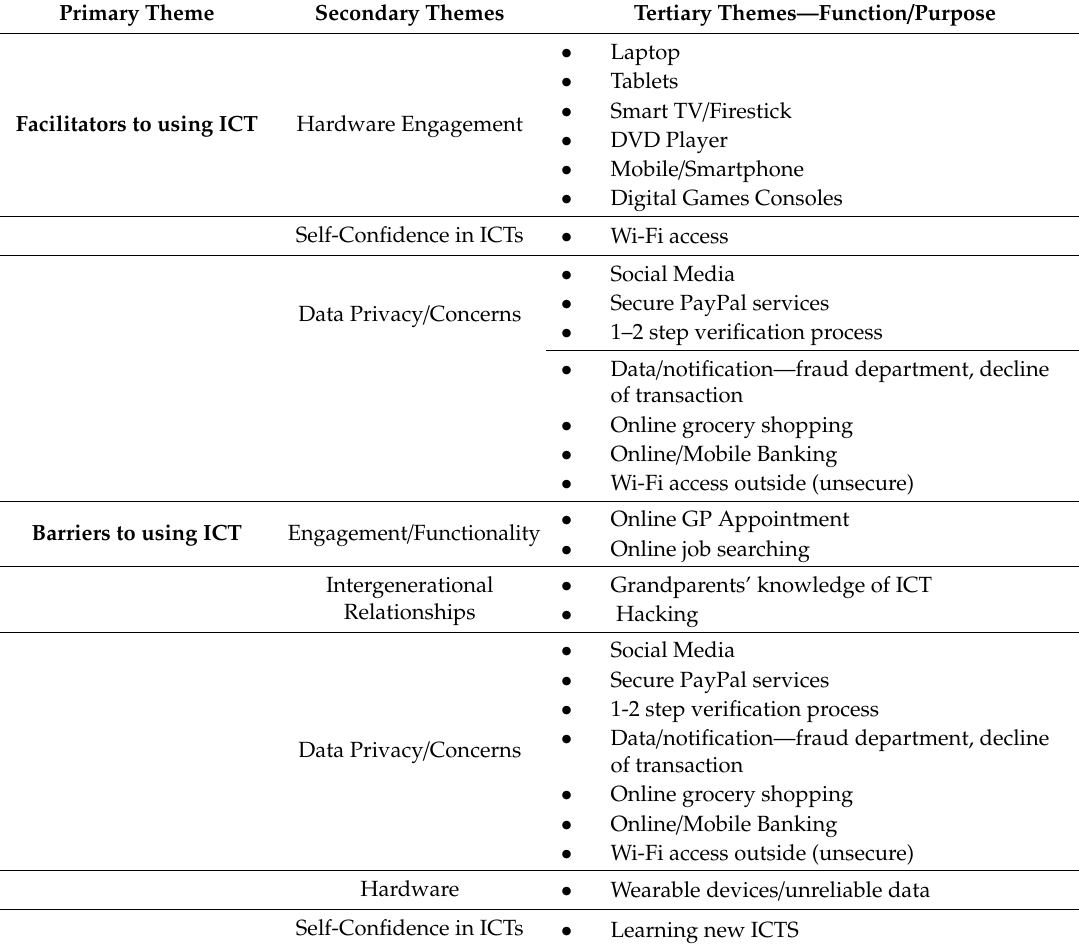
Table 3. The overarching, primary, secondary, and tertiary